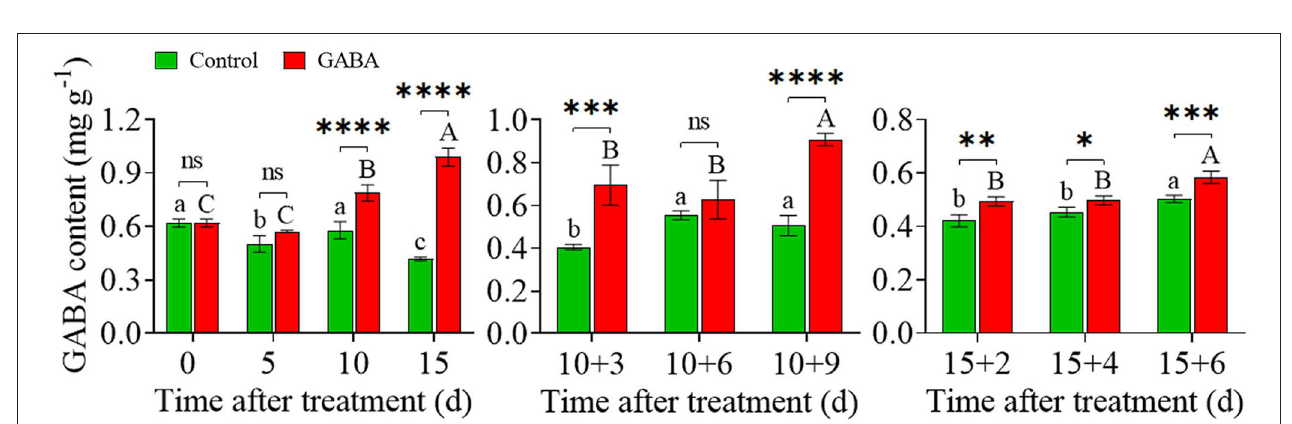
FIGURE 7 | The endogenous γ -aminobutyric acid (GABA) content in carambola fruit during storage at 4 and 25 ◦ C. Error bars are expressed as means ± SD (standard deviation) of three replicates ( n = 3). The asterisks indicate statistically significant differences between treatments at * p < 0.05, ** p < 0.01, *** p < 0.001, **** p < 0.0001, ns, not